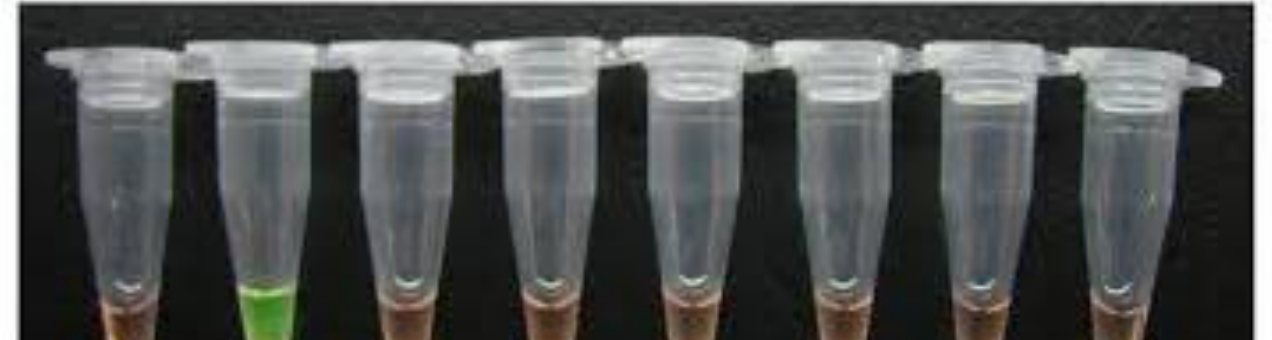
Figure 1 . Isolation of DNA samples of T. gondii and other parasites by the LAMP assay. Tubes of the LAMP reactions were visually inspected. Positive reactions turned green after the addition of SYBR Green